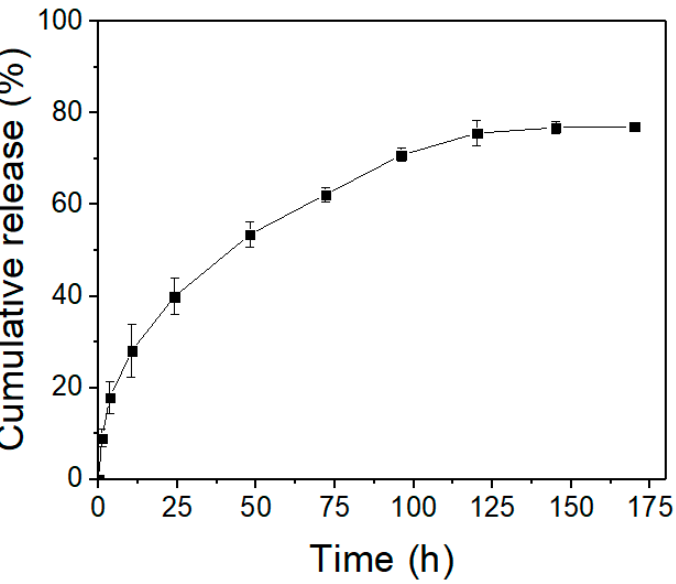
Figure 7. The injectable characterization of supramolecular